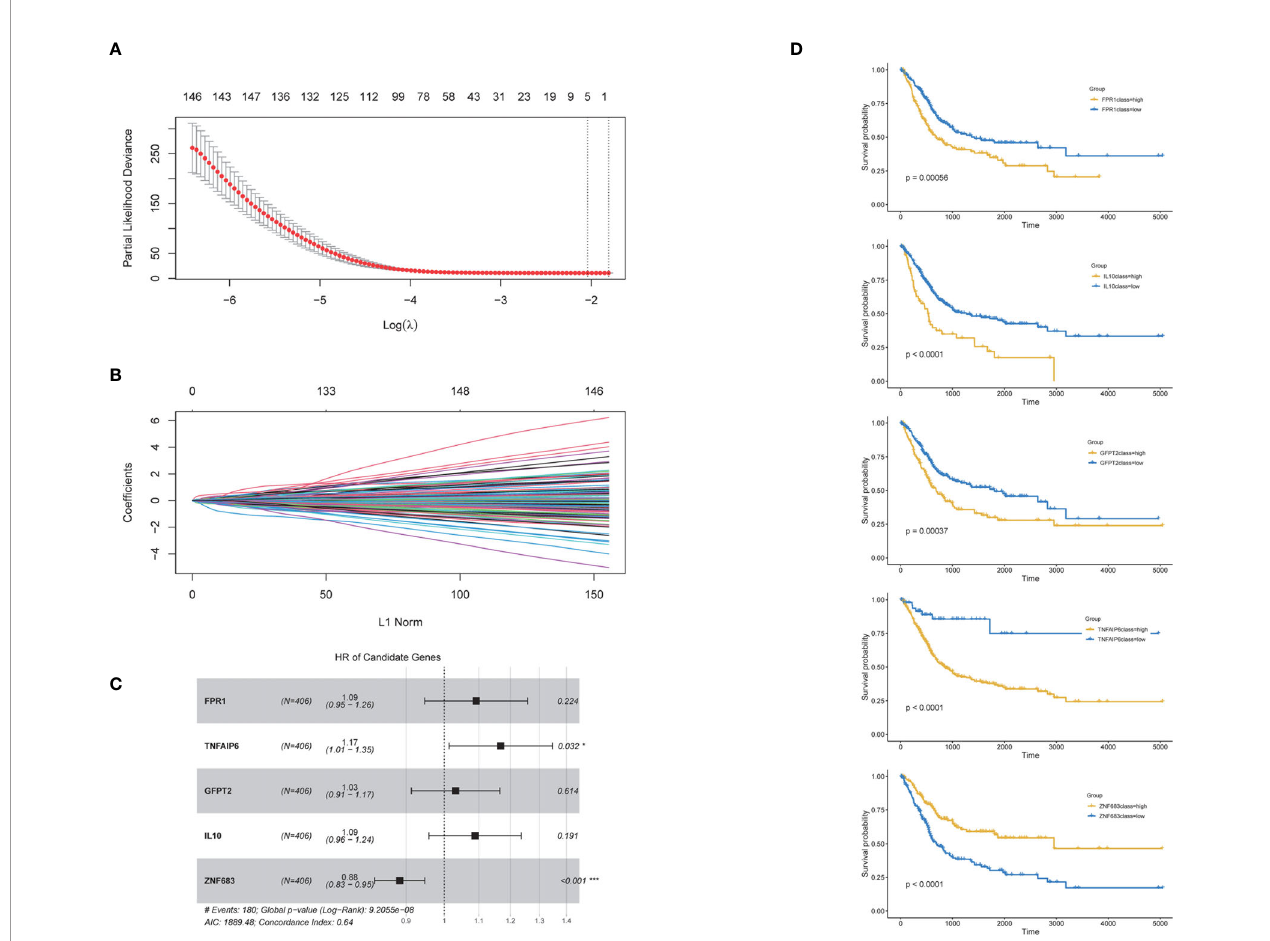
FIGURE 6 | Characteristics of the prognostic gene signature. The prognostic index was imputed as follows: (0.234 ∗ FPR1) + (0.051 ∗ TNFAIP6) + (0.145 ∗ GFPT2) + (0.106 ∗ IL-10) + ( − 0.172 ∗ ZNF683). (A) Identi fi cation of the optimal penalization coef fi cient lambda in the Lasso regression model. (B) LASSO Cox regression algorithm was used to identify the most robust prognostic genes. (C) Forest plots presenting the multivariate Cox proportional hazards regression analysis of prognostic selected genes in overall survival . (D) Kaplan – Meier curves for patients grouped by expression levels of selected